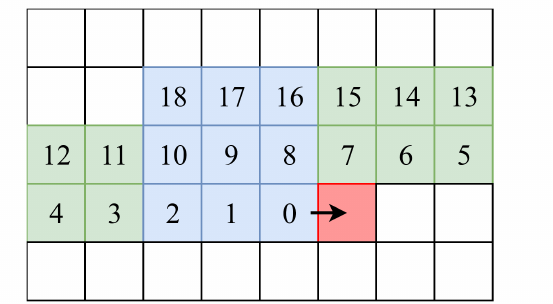
Figure 8. Shift register of an image with r = 1 and w = 8. The sliding window for pixel 9 is indicated in blue. In the next clock cycle, the red pixel will be loaded in the shift register in local